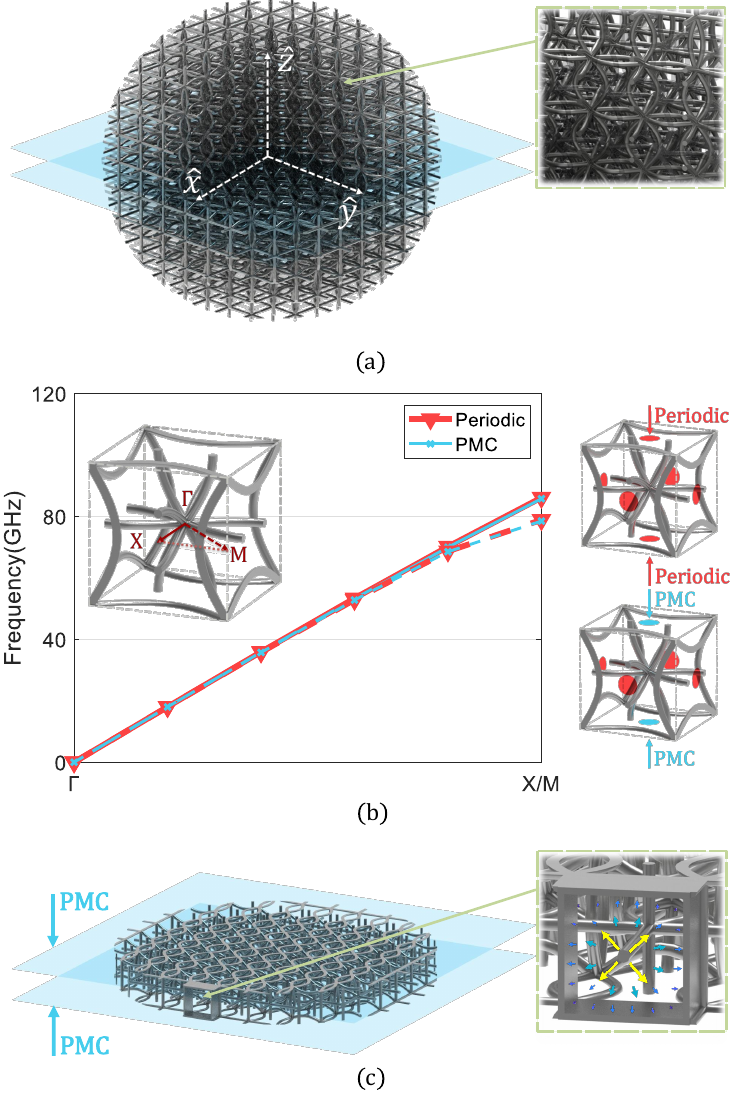
Figure 5. ( a ) 3D synthesized meta-Luneburg lens (with zoom-in view of some unit cells). ( b ) Disper- sion diagram of unit cell with different boundary conditions; the dimensions as denoted in Figure1a are p = 1mm, A = 0.2 p , and d = 0.06 p , while the solid lines represent the data for Γ X and the dashed lines for Γ M. The unit cell is defined to be the one in Figure 1c off-shifted by half the period in the x / y / z -directions. ( c ) Equivalent 2D synthesized meta-Luneburg lens (with zoom-in view of port and its field